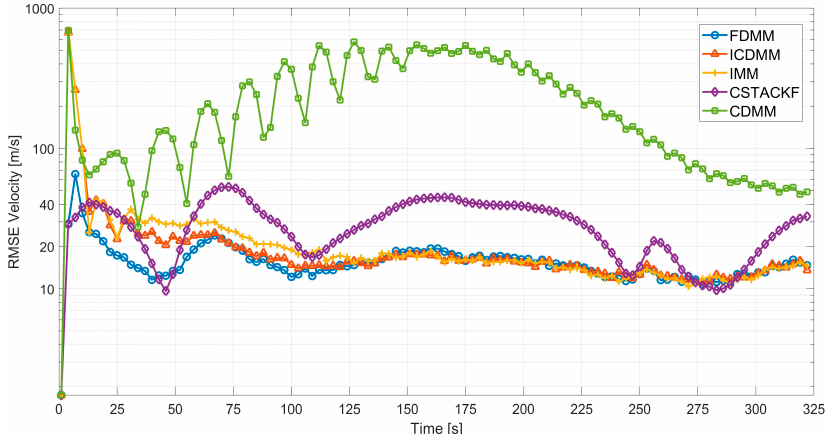
Figure 12. The comparison of velocity RMSE for different algorithms in Case 2.